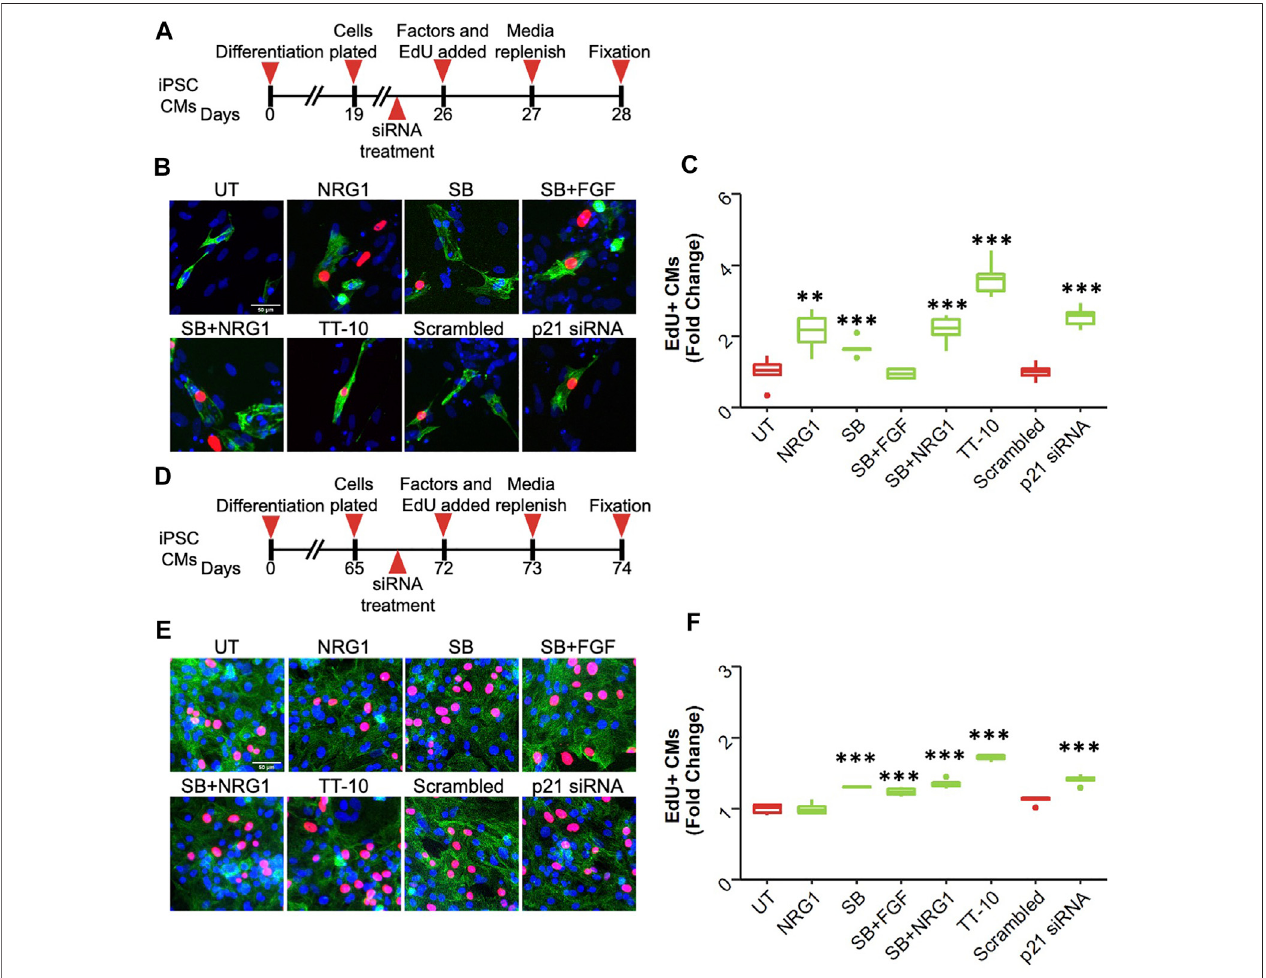
FIGURE 7 | Effect of proliferative stimuli on human induced pluripotent stem cell derived cardiomyocytes (hiPSC-CMs) (A) Schematic overview of the experiment involving immature hiPSC-CMs. (B) Representative images of EdU + immature hiPSC-CMs after each treatment. Troponin T (green), EdU (red), DAPI (blue), scale bar equals50 µm( n =6,** p < 0.01,*** p < 0.001) (C) Quanti fi cationofEdU+immaturehiPSC-CMs48 haftertreatment.* p < 0.05*** p < 0.001 (D) Schematicoverviewofthe experiment involving mature hiPSC-CMs. (E) Representative images of EdU +mature hiPSC-CMs after each treatment. TroponinT (green), EdU (red), DAPI (blue), scale bar equals 50 µm (F) Quanti fi cation of EdU + mature hiPSC-CMs 48 h after treatment. * p < 0.05 *** p < 0.001 ( n = 6 for each group).